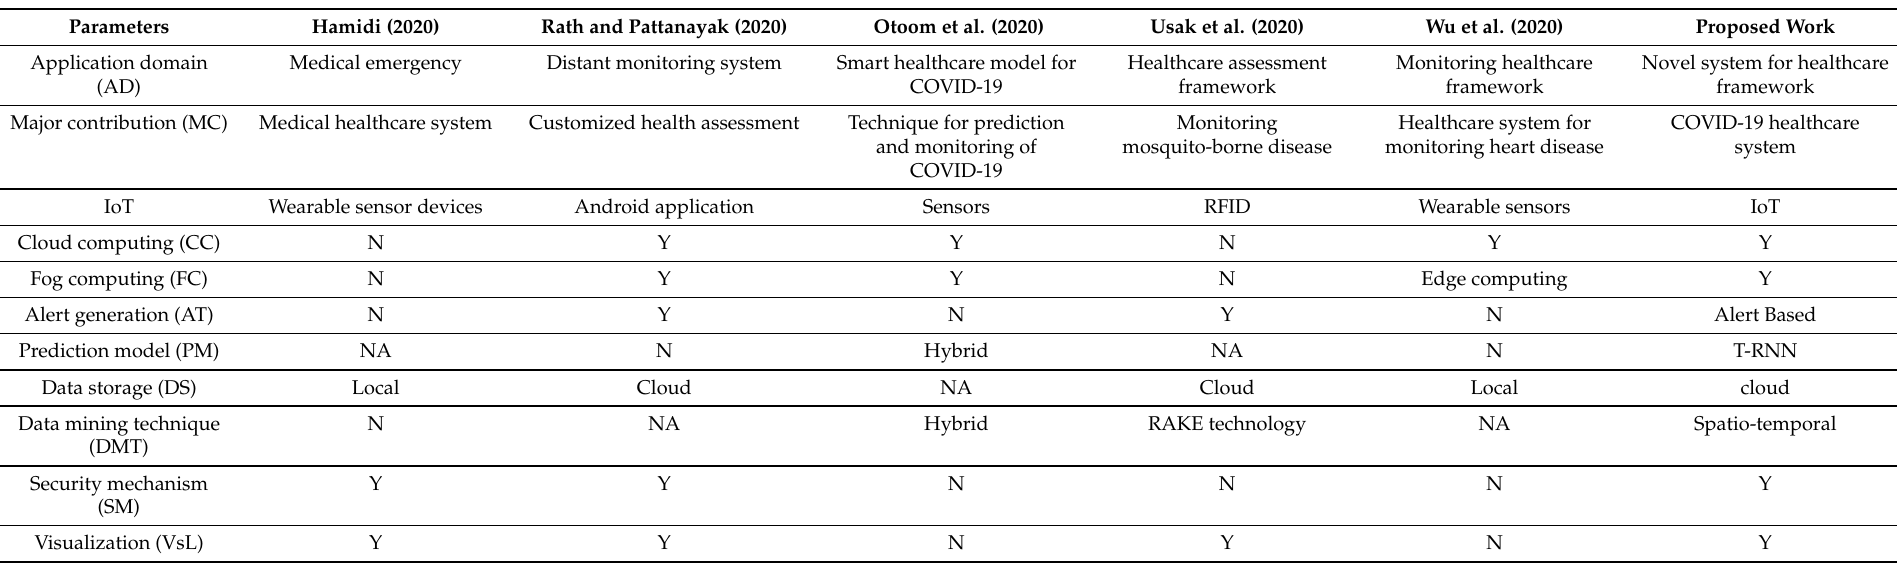
Table 1. Comparative analysis with state-of-the-art work (Y: yes, N: